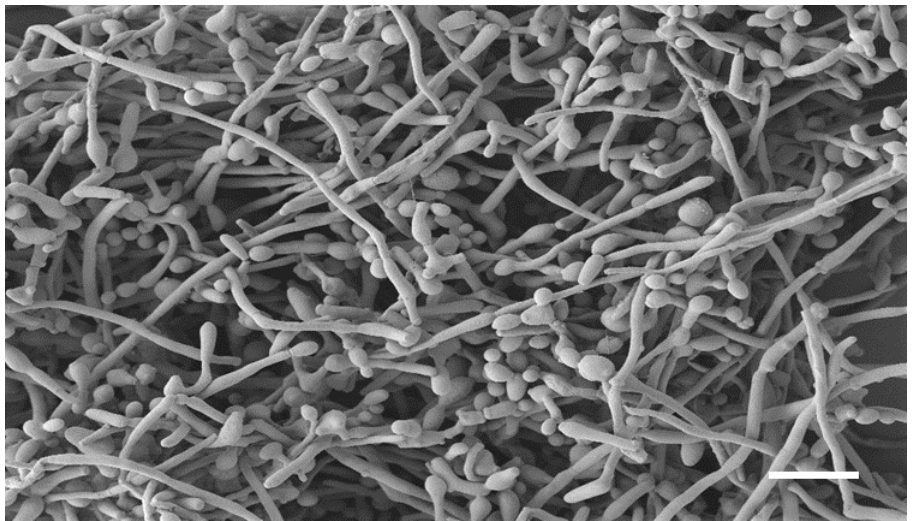
Figure 3. SEM image of the dual-species biofilm of F. oxysporum and C. albicans . Bar corresponds to 10 μ m.